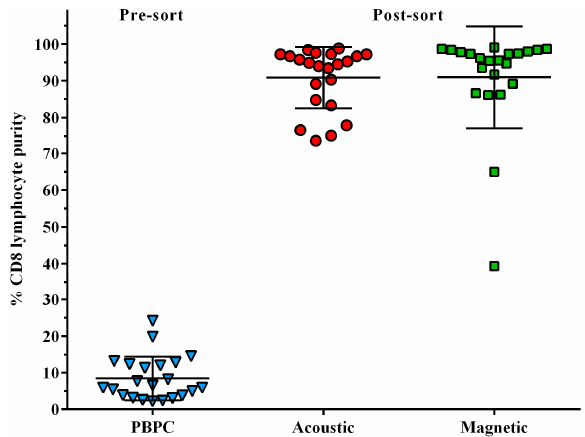
Figure 2. Frequency of CD8+ cytotoxic T cells in pre-sorted peripheral blood progenitor cell (PBPC) products and CD8+ purities following acoustic and magnetic separation post-sorted samples are shown. Both, acoustic and magnetic separation allowed effective enrichment of CD8+ cells. Data are presented as individual data points (triangles, circles, and quadrants) and corresponding means ± SD, n = 22.